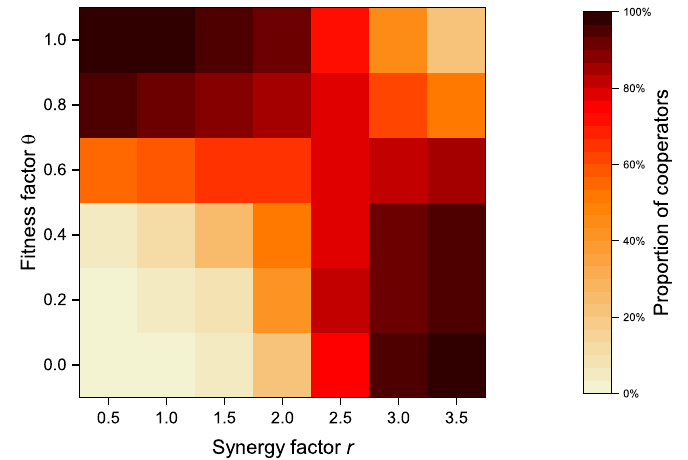
Figure 9. Relationship between fitness factor θ and synergy factor r of the model when the proportion of altruistic nodes is set to